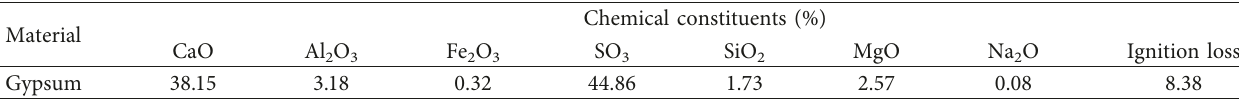
Table 3: Chemical composition of hardened gypsum.